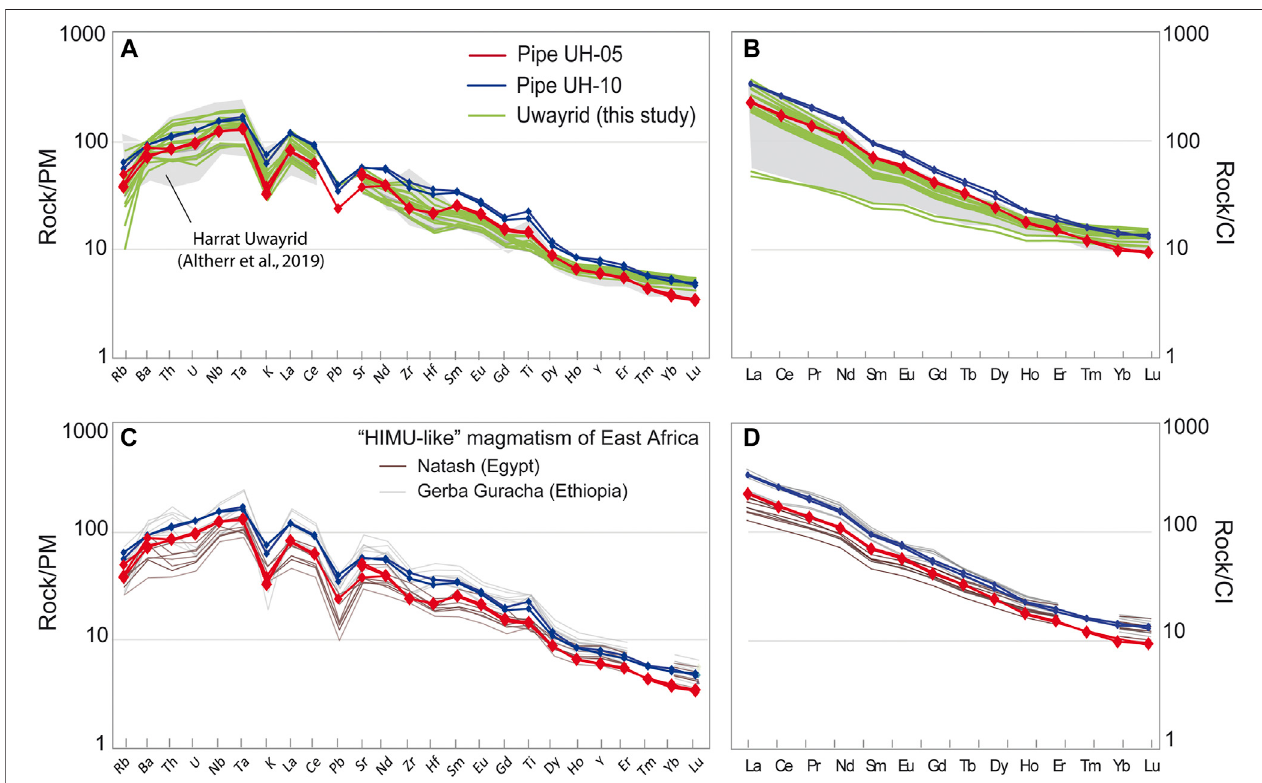
FIGURE 6 | Primitive mantle-normalized (A , C) and chondrite-normalized (B , D) (Sun and McDonough, 1989) diagrams of samples from Harrat Uwayrid and Marthoum volcanic pipes. Representative compositions of lava fi elds from East Africa retaining HIMU-like isotopic compositions are also reported for comparison.